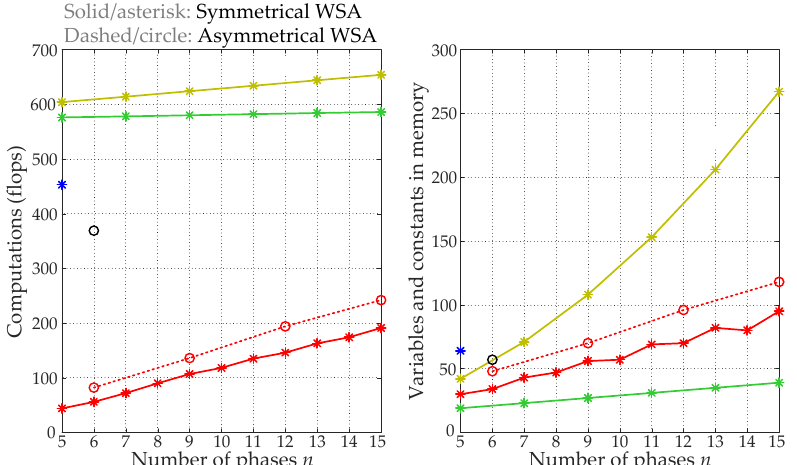
Figure 28. Computational burden, in terms of number of floating-point operations (flops) and constants/variables in memory, among several overmodulation methods that avoid α 1 - β 1 low- frequency distortion [143]: two large neighboring voltage vectors [146,148,152] (green), SV PWM with minimum x - y distortion and no common mode for n = 5 [151] (blue), SV PWM with mini- mum x - y distortion and no common mode for odd n [152] (beige), SV PWM with minimum x - y distortion for n = 6 with asymmetrical WSA [158] (black), and simple CB PWM with high dc-link utilization [142,143]